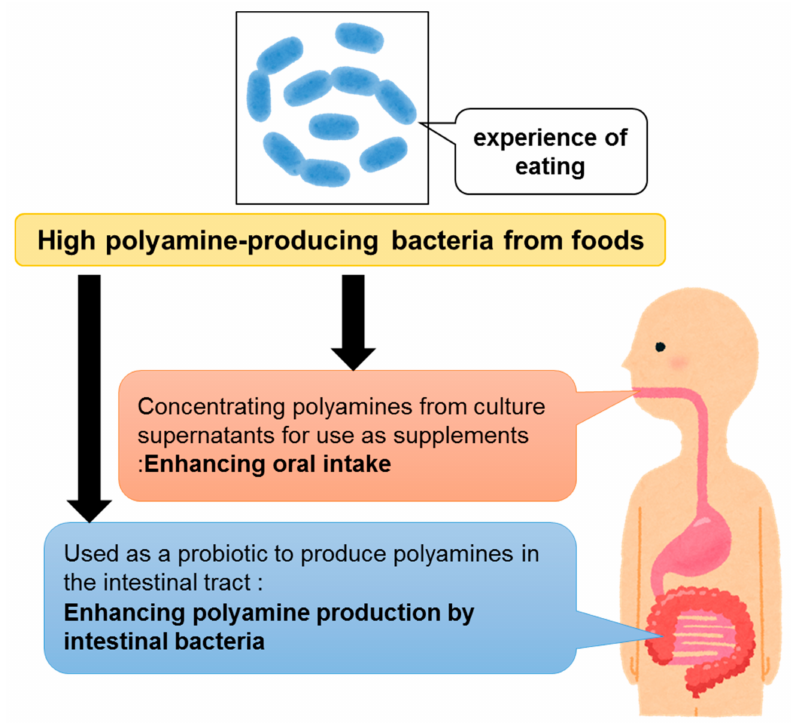
Figure 2. Significance of isolating high polyamine-producing bacteria from